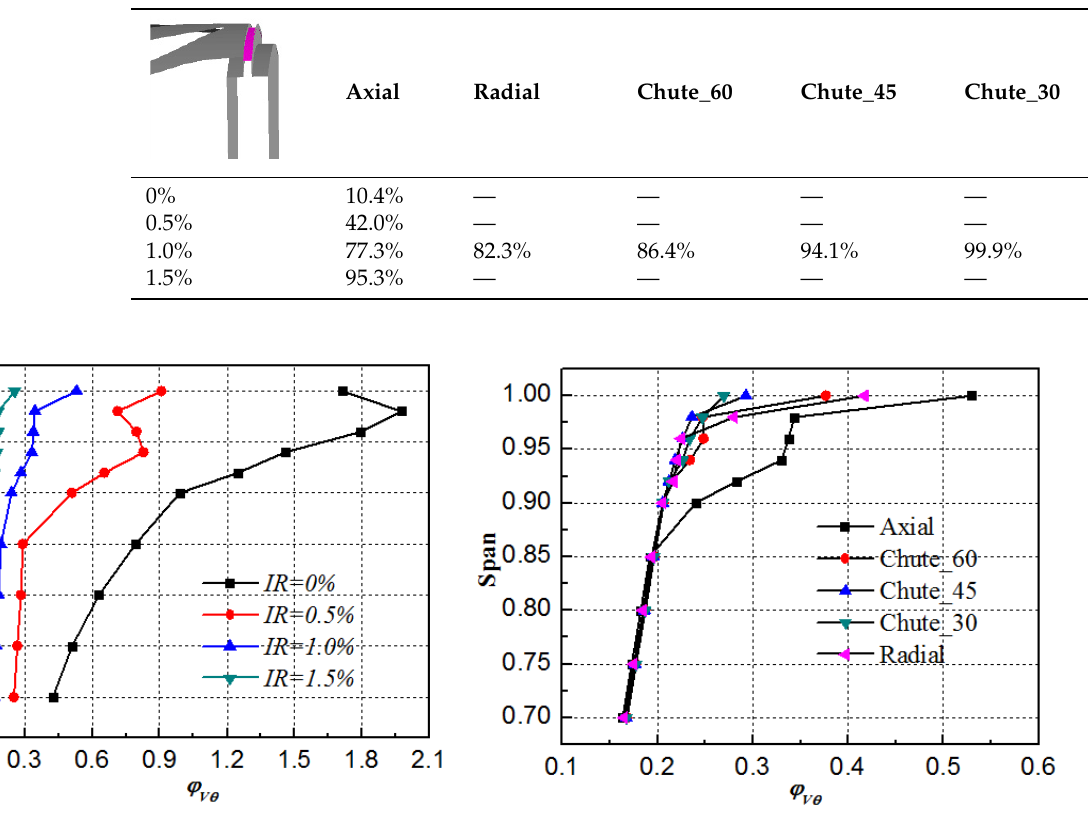
Figure 11. Time-averaged tangential velocity distribution. Table 4. Time-averaged sealing efficiency.